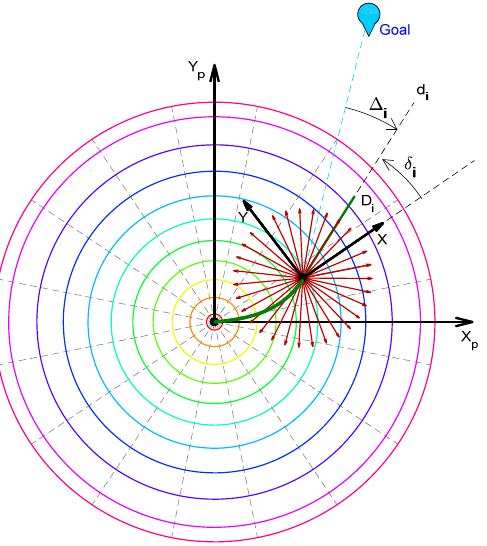
Figure 15. Illustration of direction selection over the